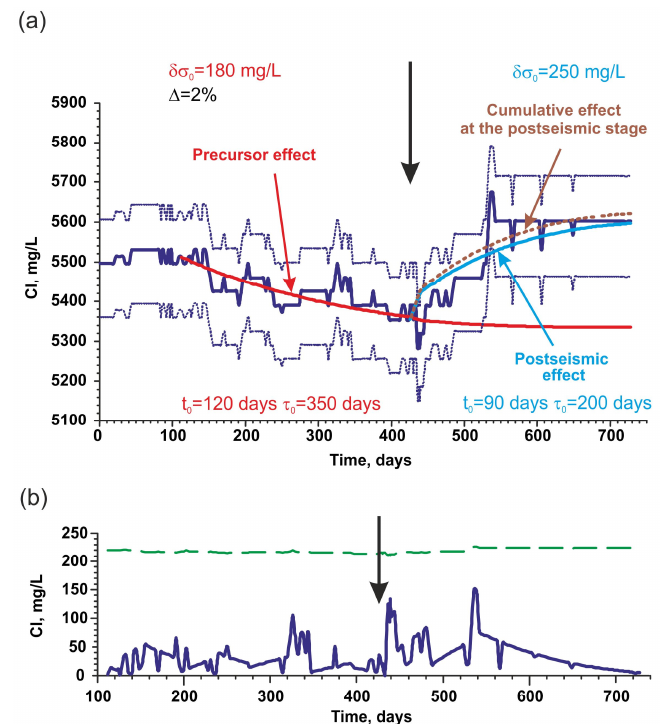
Figure 7. ( a ) Change in the Cl − concentration in water from well GK-1 due to the 2 March 1992 earthquake (earthquake moment—black arrow) and modeling results of precursory anomaly at t 0 = 120 days, τ 0 = 350 days and postseismic anomaly at t 0 = 90 days, τ 0 = 200 days according to (3). Blue line—observational data; blue dashed lines–intervals of Cl − concentration changes, taking into account the determination error of ∆ Cl = 2% according to (1); solid lines—calculated changes of Cl − concentration at precursory anomaly (red color) and postseismic anomaly (blue color); brown dashed line—the total effect of two processes at postseismic stage. ( b ) Change in absolute values of difference between the measured concentrations of Cl − and calculated values (blue solid line) in comparison with double error of determining each value of Cl − concentration (green dashed